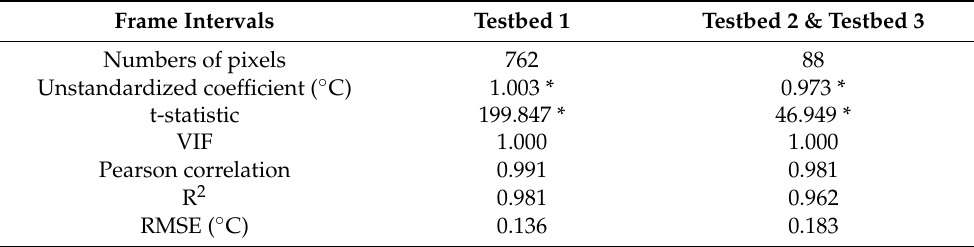
Table 5. Results of the ordinary least squares linear regression with SCSTs (°C) in matched hot spots between the photo-mosaic and video-mosaic.